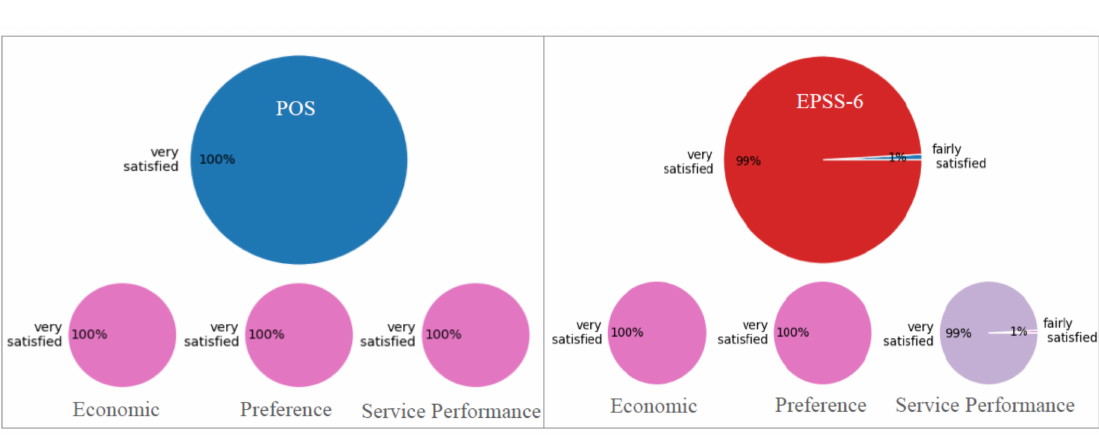
Figure 13. POS & EPSS Customers’ Satisfaction